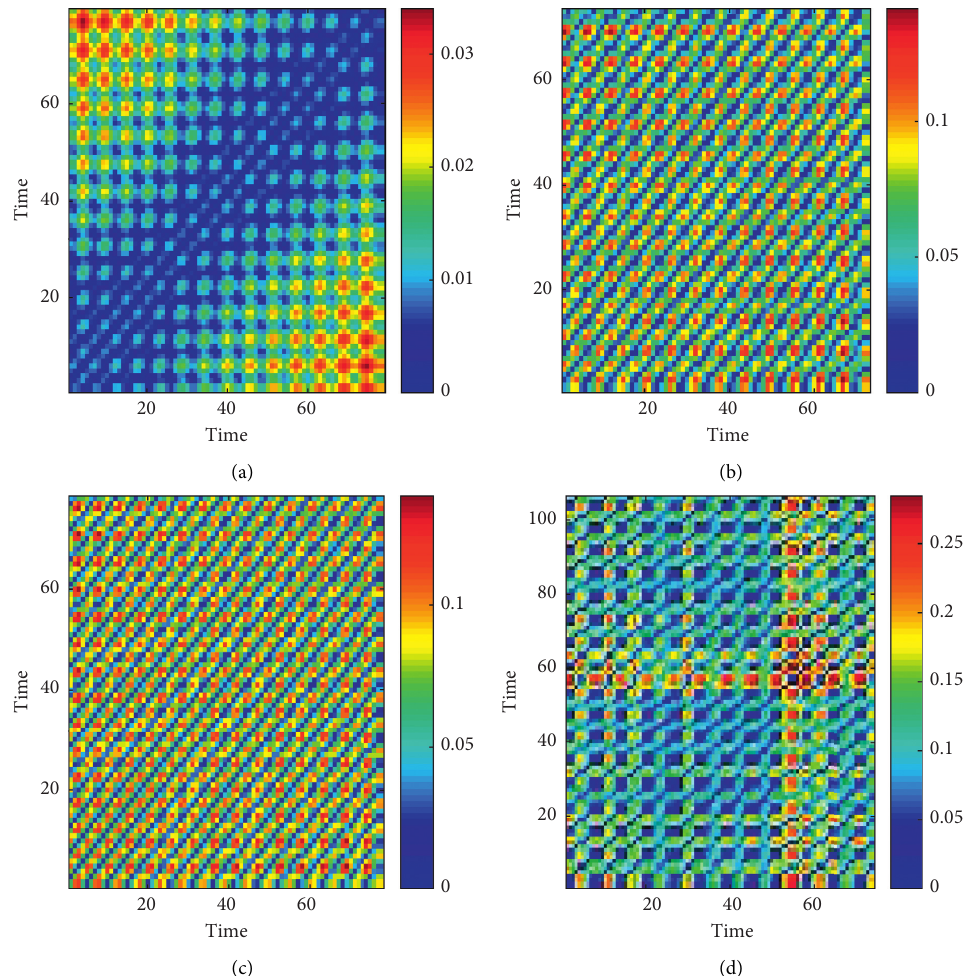
Figure 6: (a) and (b) represent [ w ( i,j )] matrix plots for system (13) with f � 0 . 001 and 0.012, respectively. In order to calculate [ w ( i,j )] 0 matrix, we solve system (13) with the initial condition ( 0 , − 0 . 0032 ) . Same plots are represented in (c) and (d) with respect to the different � 0 . 012. In both the cases, the values of parameters are considered same, as initial conditions ( 0 , − 0 . 00161 ) , ( 0 , − 0 . 00261 ) for fixed f 0 chosen in Figure 2. In each calculation, we consider last 10,000 points on the